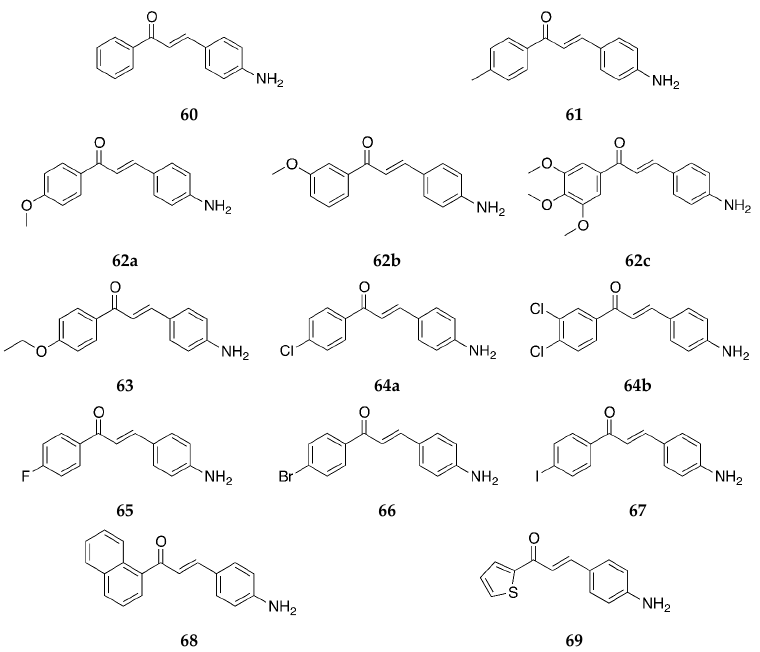
Figure 34. Chemical structures of 4′-aminochalcone and its derivatives with substitutions on ring A. Table 18. Cytotoxic effect of compounds 60 , 61 , 62a – c , 63 , 64a , 64b , and 65 – 69 against murine leukemia L1210, murine mammary carcinoma FM3A, human T-leukemia Molt/4 and CEM, and human cervix carcinoma HeLa cancer cells (IC 50 values in µM) .